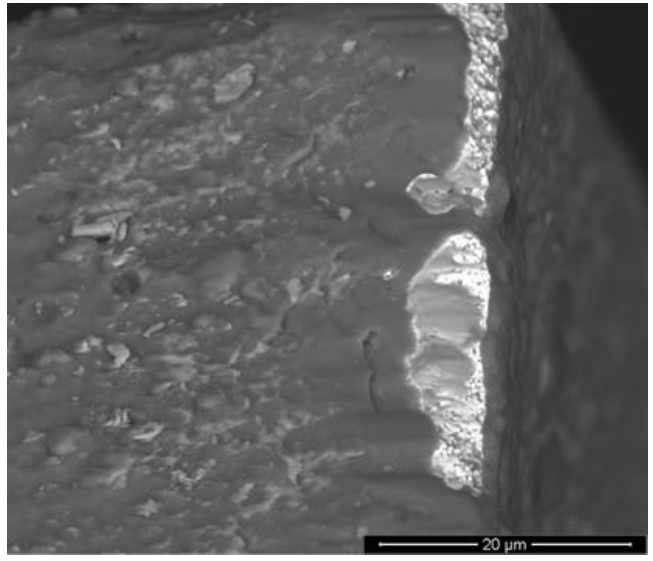
Figure 10. Adhered material in the T2 tool’s flank, tested under the T2L2F100 condition.